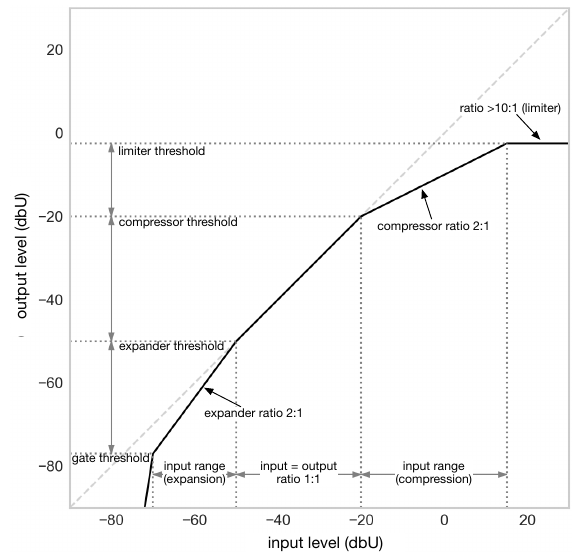
Figure 6. Parameters for gate, expander, compressor, and limiter.